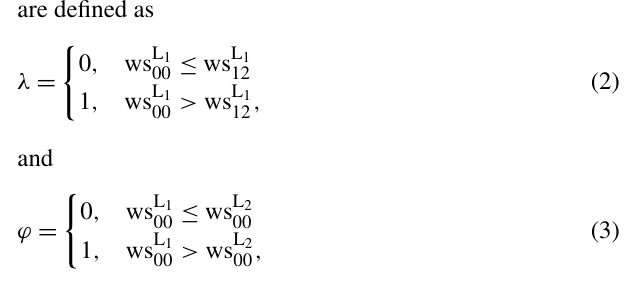
T25 is plotted in Figs. 8 and 9. The most distinct feature